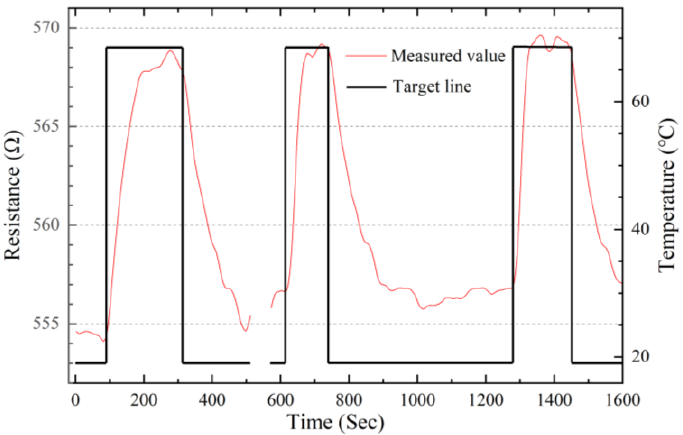
Figure 4. Heating response of ITO microheater to a target temperature read by ITO microsensor.